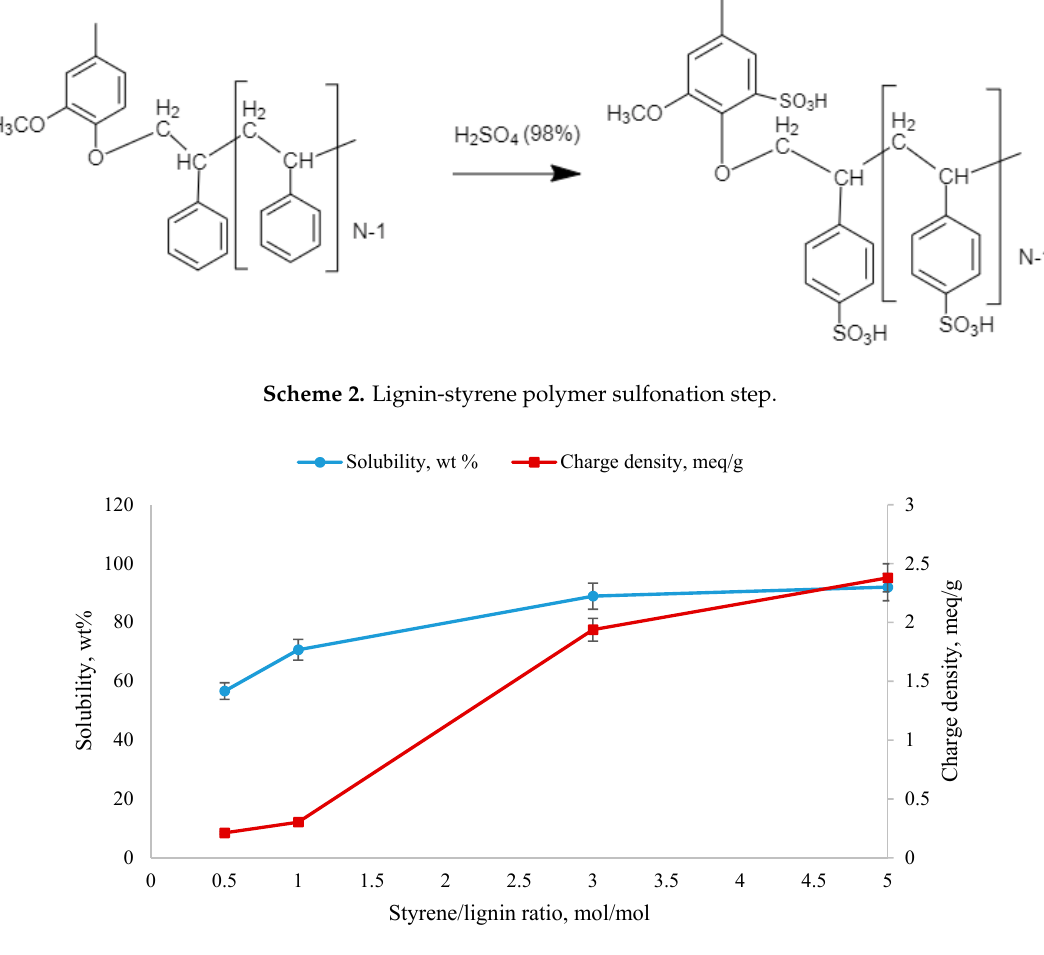
Figure 2. Charge density and solubility of KL- g -SPS polymers in 10 g/L water solution (experiments were performed under the conditions of KL- g -PS/sulfuric acid 1/10 wt/v and 90 °C for 1 h).